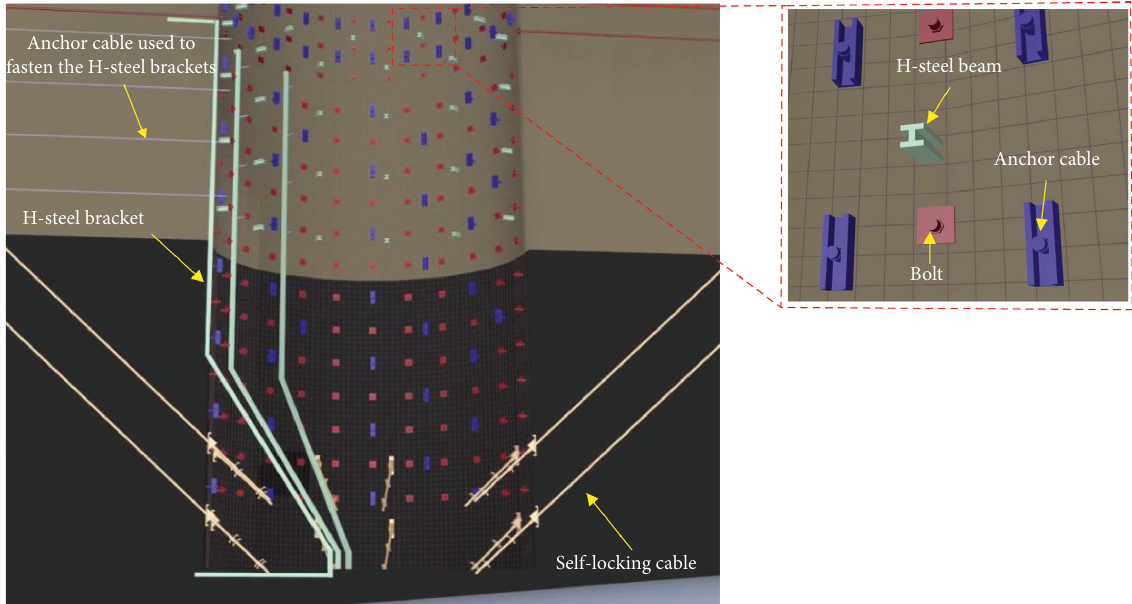
Figure 15: 3D view of the bearing structure of the WMCB.